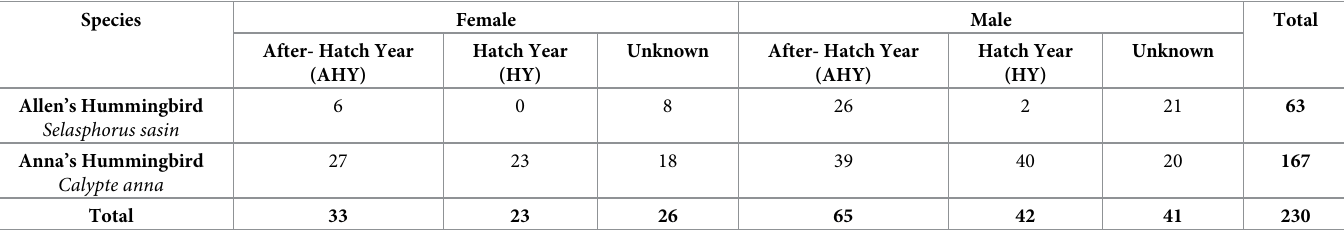
Table 1. Demographic composition of hummingbirds (n = 230) tagged with passive integrated transponders at Sites 1 and 2 in Northern California and Site 3 in Southern California. Species Female Male Total After- Hatch Year Hatch Year Unknown After- Hatch Year Hatch Year (AHY) (HY) (AHY) (HY)